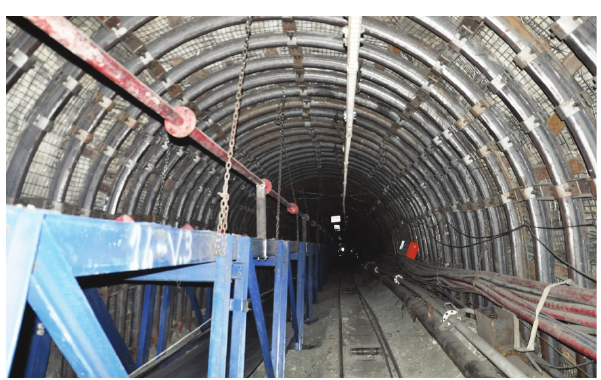
Figure 2: General view of the gallery